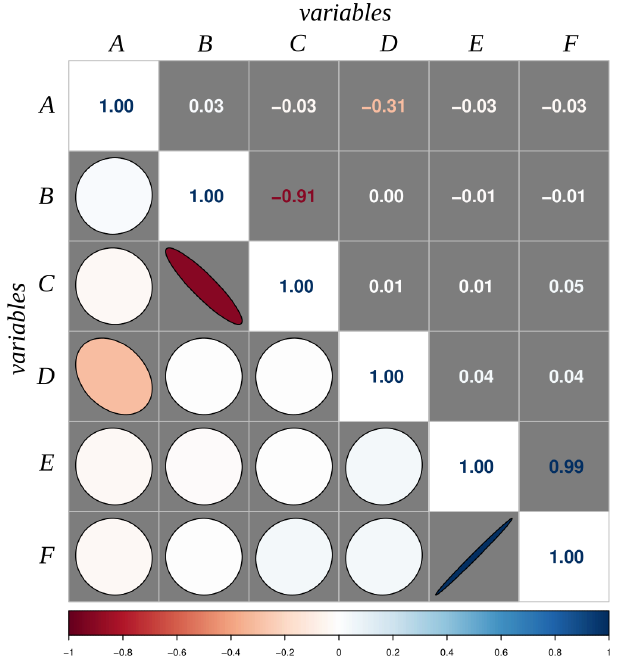
Figure 4. Example of the graph showing the output of the pairwise correlation analysis generated by